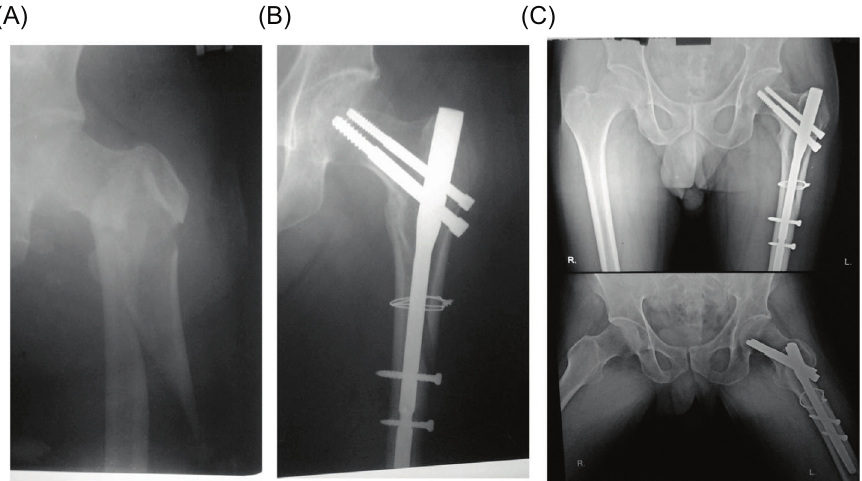
Figure 2. A 70-year-old female. (A) The initial preoperative radiographs. (B) Radiograph six weeks postoperatively with cerclage wire. (C) Anteroposterior radiograph at eight months postoperatively demonstrating the fracture